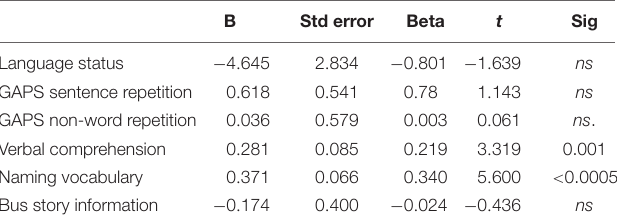
LUI-6 factor GAPS: sentence GAPS: non-word BAS: verbal score repetition repetition